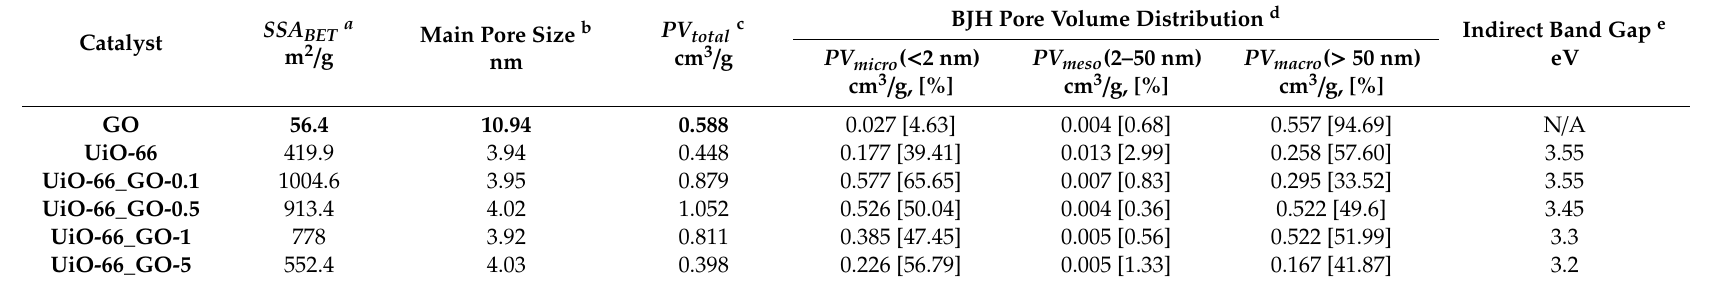
Table 1. Surface area, pore size, pore volume, and indirect band gap of GO, UiO-66, and